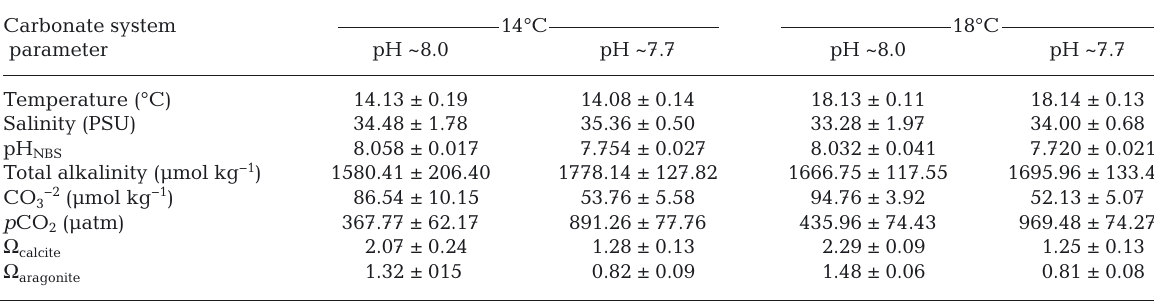
Table 1. Carbonate system parameters (mean ± SE) registered at each experimental treatment combining present-day (low p CO 2 /pH ~8.0) and future acidification conditions (high p CO 2 /pH ~7.7) with temperatures dominating in Tongoy Bay, Chile, during the experimental period (14°C) and under warmer conditions (18°C). NBS: National Bureau of